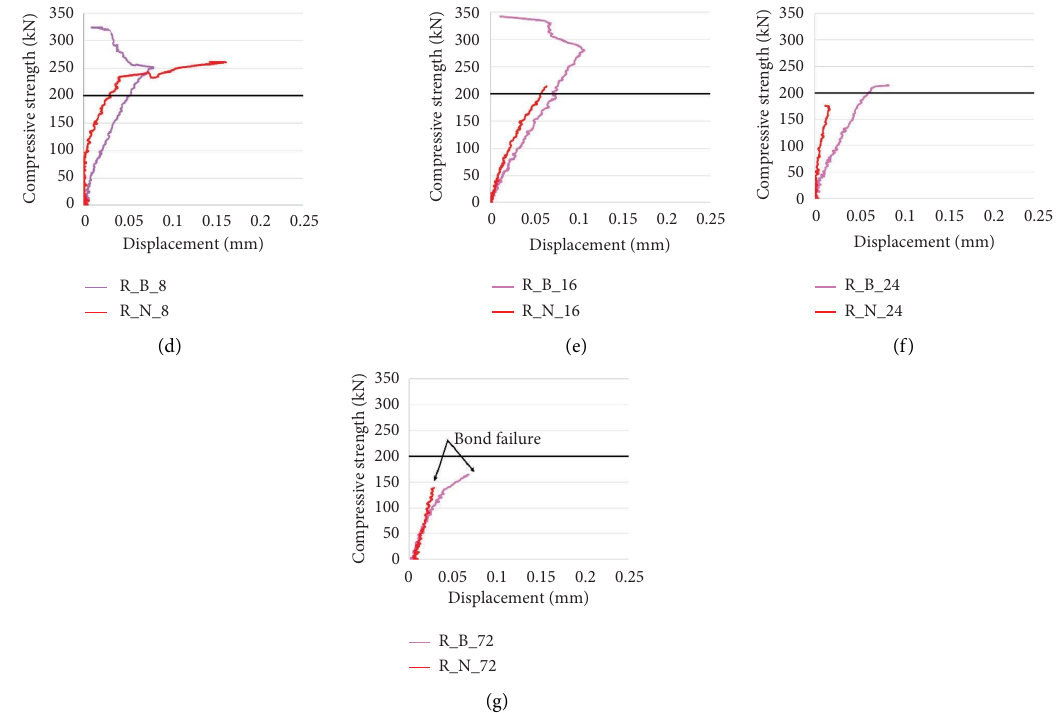
Figure 8: Relative displacement and maximum loads on the 28 th